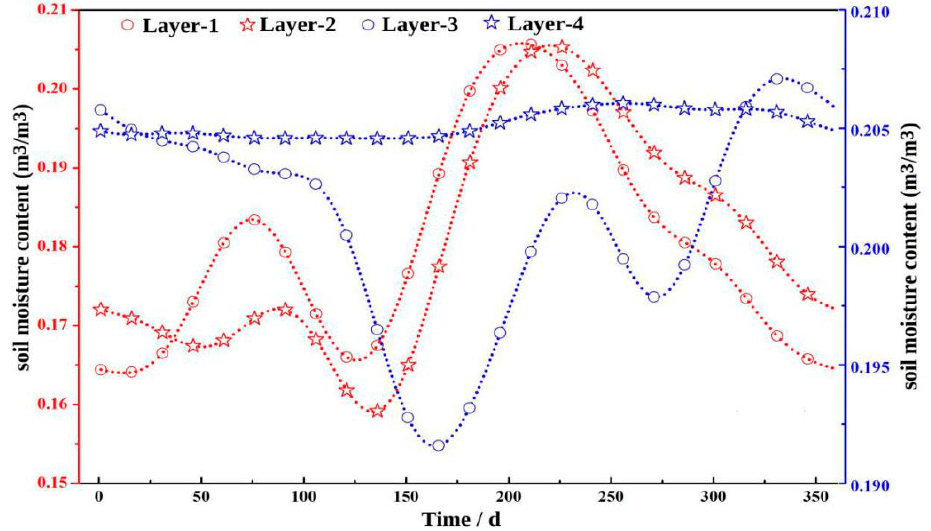
Figure 4. Trends of daily soil moisture an average of the 1982–2015 year at various depths in MP.